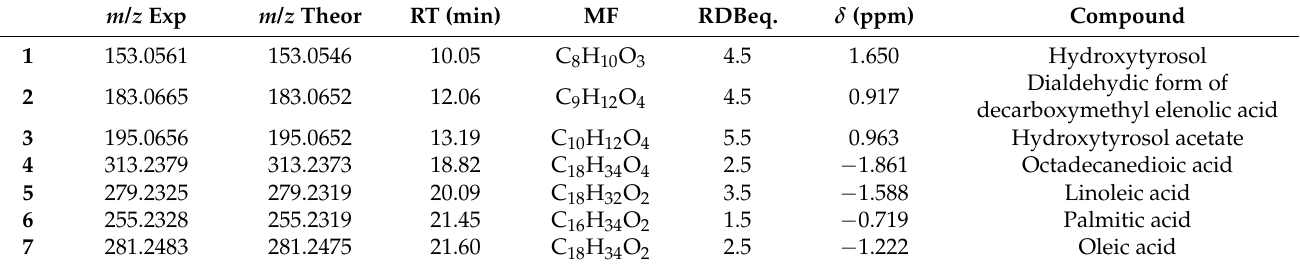
Table 2. Identified compounds in the extract of the hydroxytyrosol (HT) capsule. The identification parameters are presented in each column. m / z exp: experimental m / z ; m / z theor: theoretical m / z